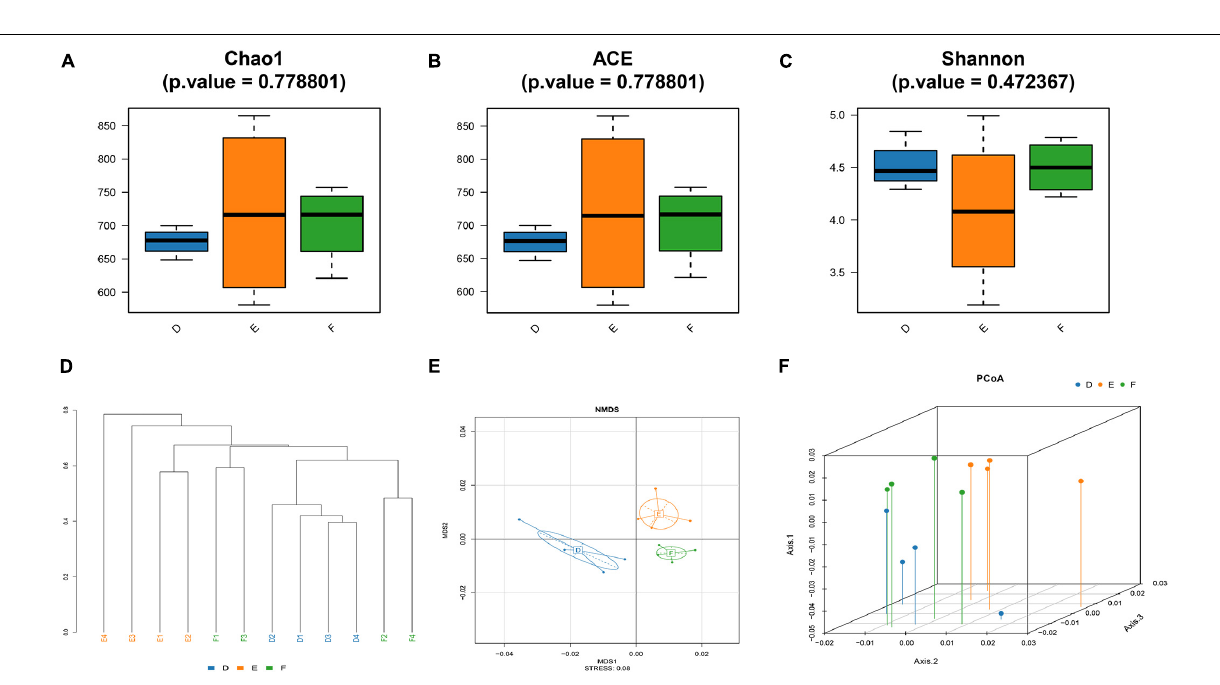
Frontiers in Nutrition |